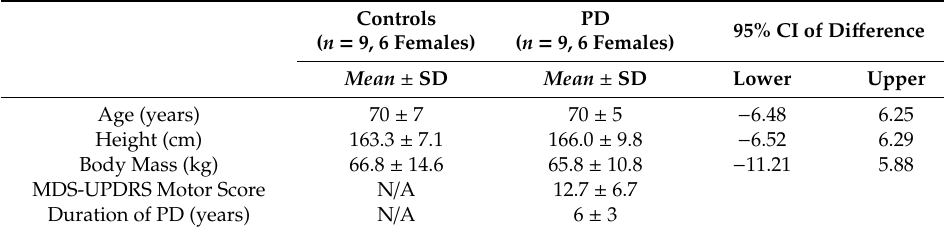
Table 1. Participant